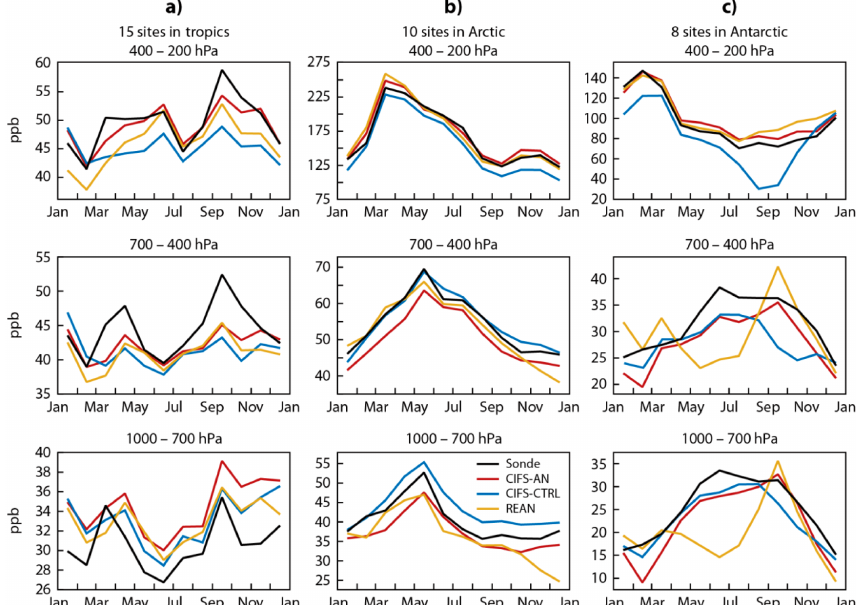
Figure 15. Time series of monthly mean tropospheric O 3 in ppb over (a) tropics (15 stations), (b) Arctic (10 stations) and (c) Antarctic (8 stations) averaged in the pressure bands 1000–700hPa (bottom), 700–400hPa (middle) and 400–200hPa (top) from ozonesondes (black), CIFS-AN (red), CIFS-CTRL (blue) and REAN (orange) in 2008.